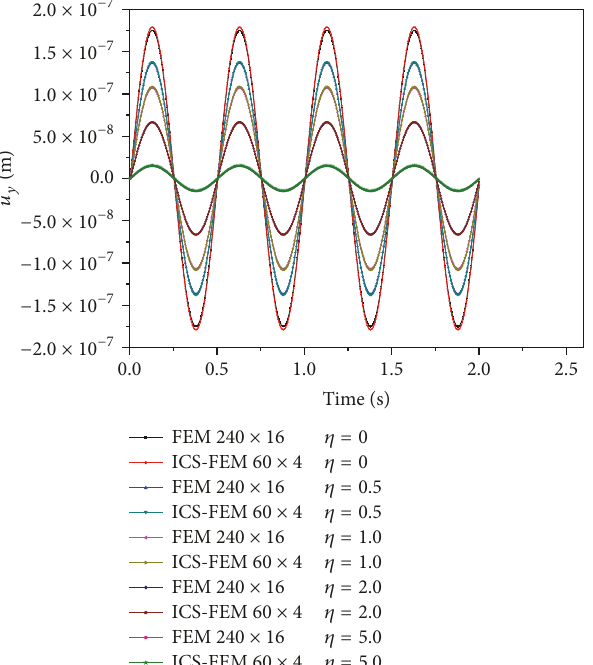
Figure 16: Temporal variations of displacement 𝑢 𝑦 at point 𝐵 of BaTiO 3 FGMEE energy harvester with different values of exponen- tial factor calculated by ICS-FEM and FEM.